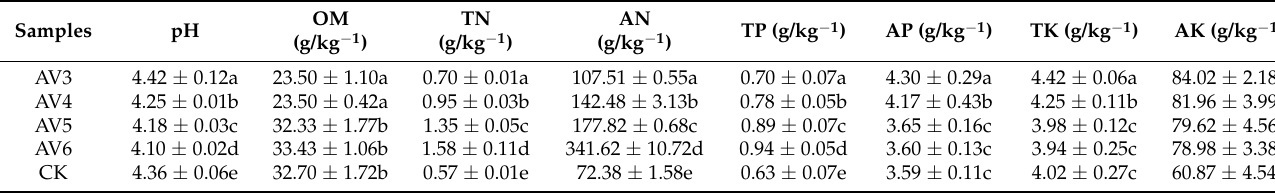
Table 1. Soil chemical properties among the examined fields.